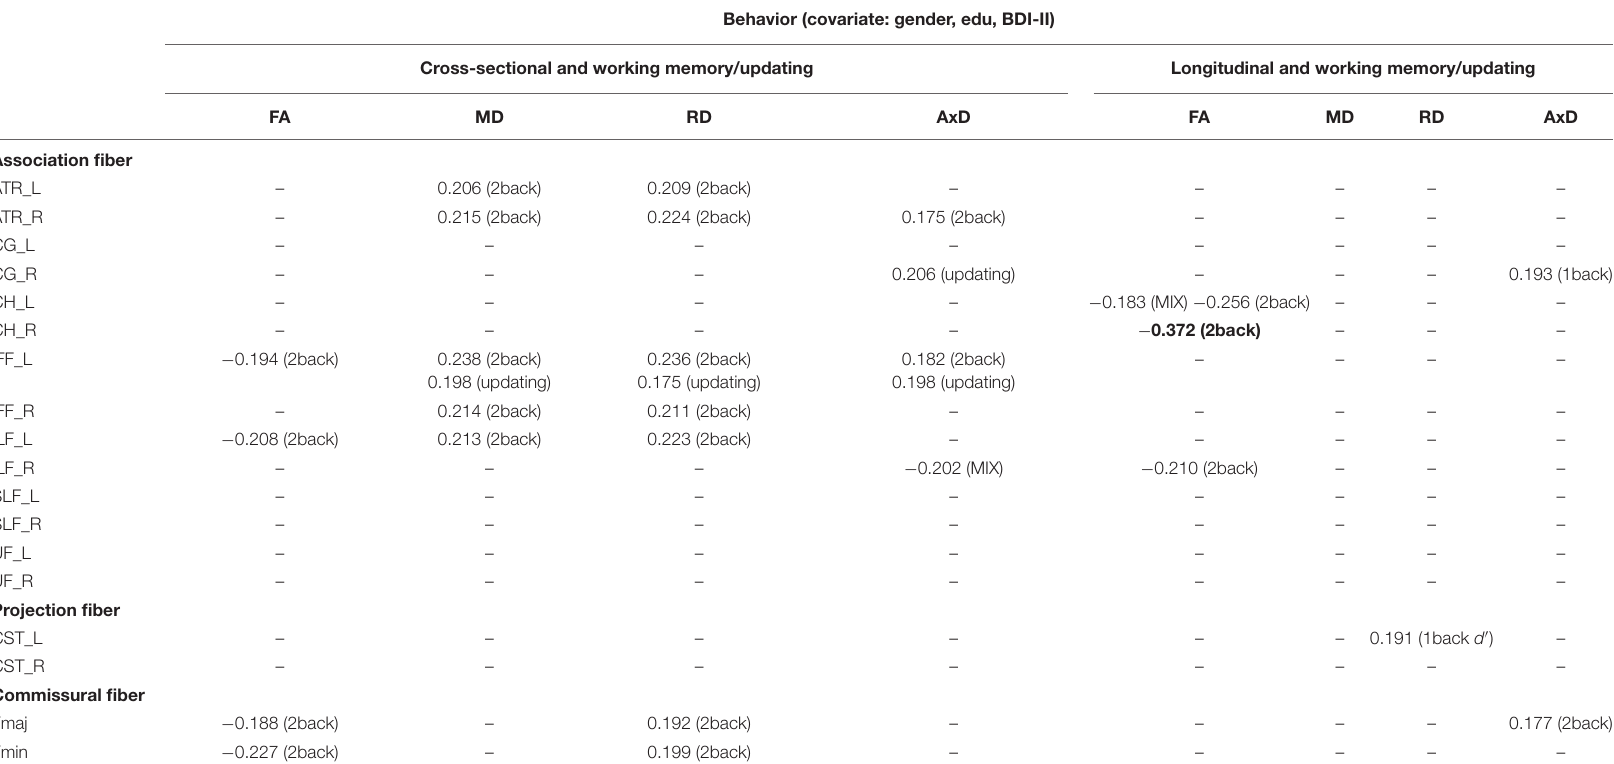
TABLE 7 | The significant Pearson correlation r values for the working memory/updating component and DTI measures (FA, MD, RD, and AxD for cross-sectional and longitudinal ratio scores. Behavior (covariate: gender, edu, BDI-II) Cross-sectional and working memory/updating Longitudinal and working